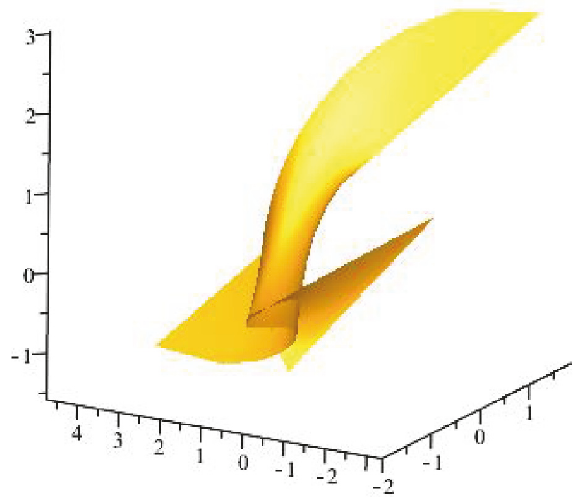
Figure12:Projectionoftheintersectionof IH 𝛾 ± (𝑠,𝜇,𝜔) and 𝜔 = 0 on 𝑥 1 𝑥 2 𝑥 4 -space.